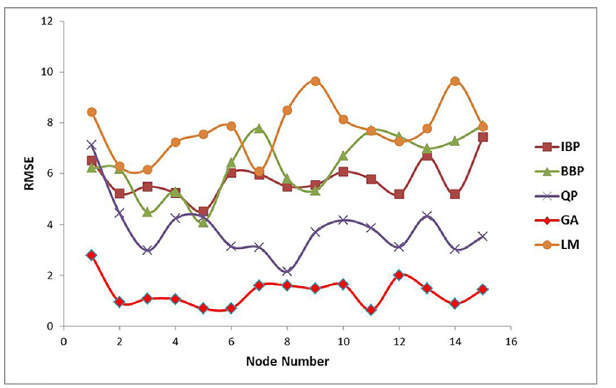
Fig 1. The selected RMSE vs. node number of the VCO nanoemulsions network ’ s hidden layer for IBP, BBP, QP, GA and LM. The lowest RMSE belongs to node number 5 (IBP), 5 (BBP), 8 (QP), 11 (GA), and 7